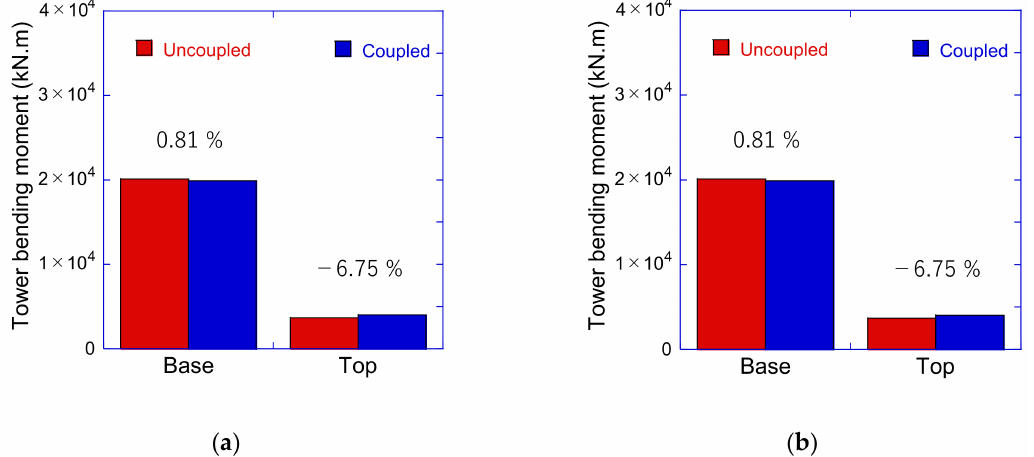
Figure 16. The fore-aft tower bending moment at the tower base and the top during power production under severe sea state. ( a ) Mean tower bending moment, ( b ) maximum tower bending